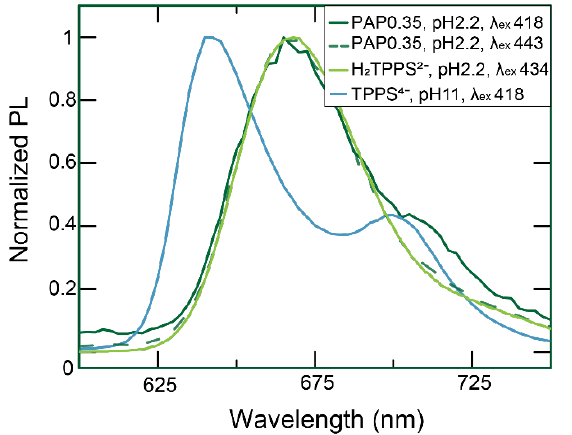
Figure 4. Overall perspective of the emission spectra of SNPs. The normalized emissive spectra of the nanohybrid sample prepared with SNPs at PAP = 0.35 nm 2 were compared with the spectra of H 2 TPPS 2− (pH = 2.2) and TPPS 4− (pH = 11) as references. H 2 TPPS 2 − (pH = 2.2) and TPPS 4 − (pH = 11) as